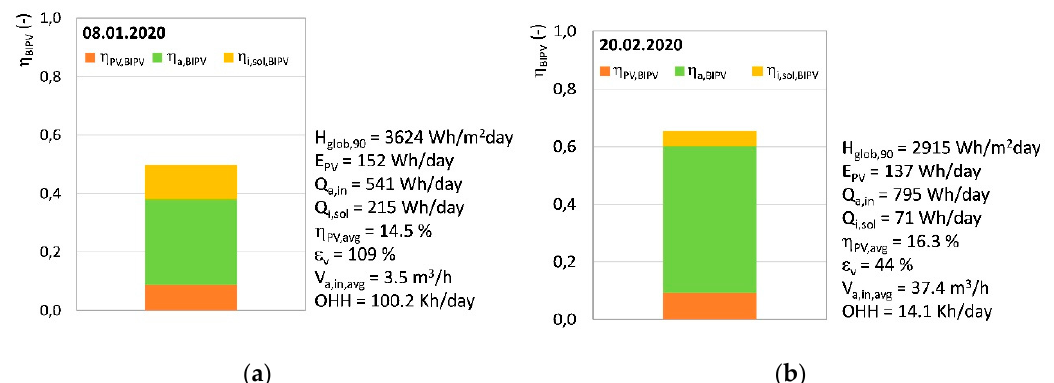
Figure 8. Overall efficiency of solar energy utilization η BIPV of the pilot BIPV glazed façade structure ( a ) on 8 th January 2020 and ( b ) on 20 th February 2020; in the case ( a ) the ventilation air flow rate , a in V